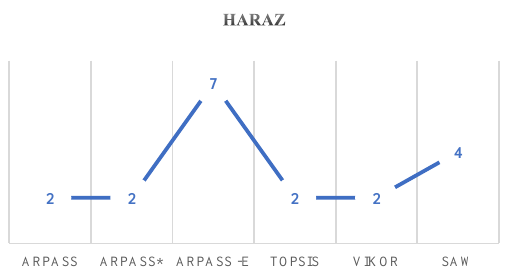
Figure 12. Rank fluctuation of Pegah in the investigated MCDM methods.